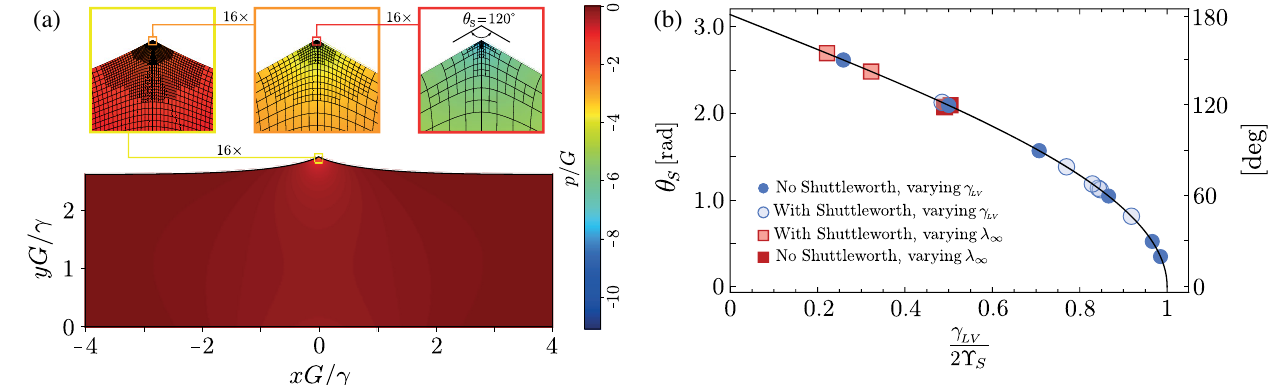
FIG. 1. Symmetric wetting ridges under large deformation induced by a localized contact line force, with and without the Shuttleworth effect. (a) Typical numerical solution using a finite-element method, where successive magnifications show the adaptive resolution of the elastocapillary ridge. The example is a case without the Shuttleworth effect, with equal liquid and solid surface energies γ (giving a ¼ 120 °). The scales are expressed in the corresponding elastocapillary length γ =G . (b) The solid angle θ solid angle θ S of liquid-vapor surface tension γ and solid surface tension ϒ . Symbols are numerical results with the Shuttleworth effect (open S LV symbols, ϒ measured at the contact line) and without the Shuttleworth effect (closed symbols). We vary both γ S amount of prestretch of the substrate from λ ∞ ¼ 1 to 2 (squares). The solid line corresponds to Neumann ’ s law (15), with ϒ value at the contact